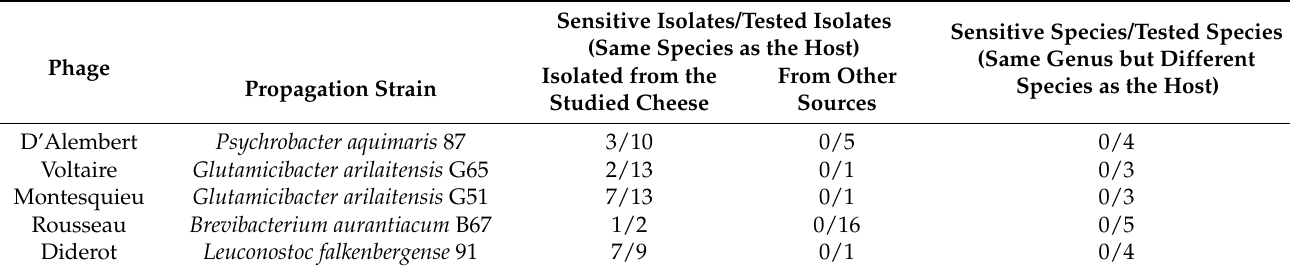
Table 4. Host spectrum of the 5 tested